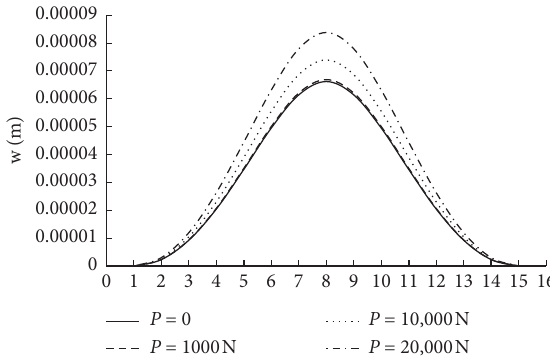
Figure 3: S-S EB Beam (2) axial load, F � 30 N.